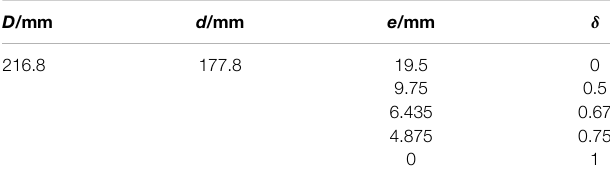
TABLE 2 | The casing centering δ and their corresponding eccentricity e .